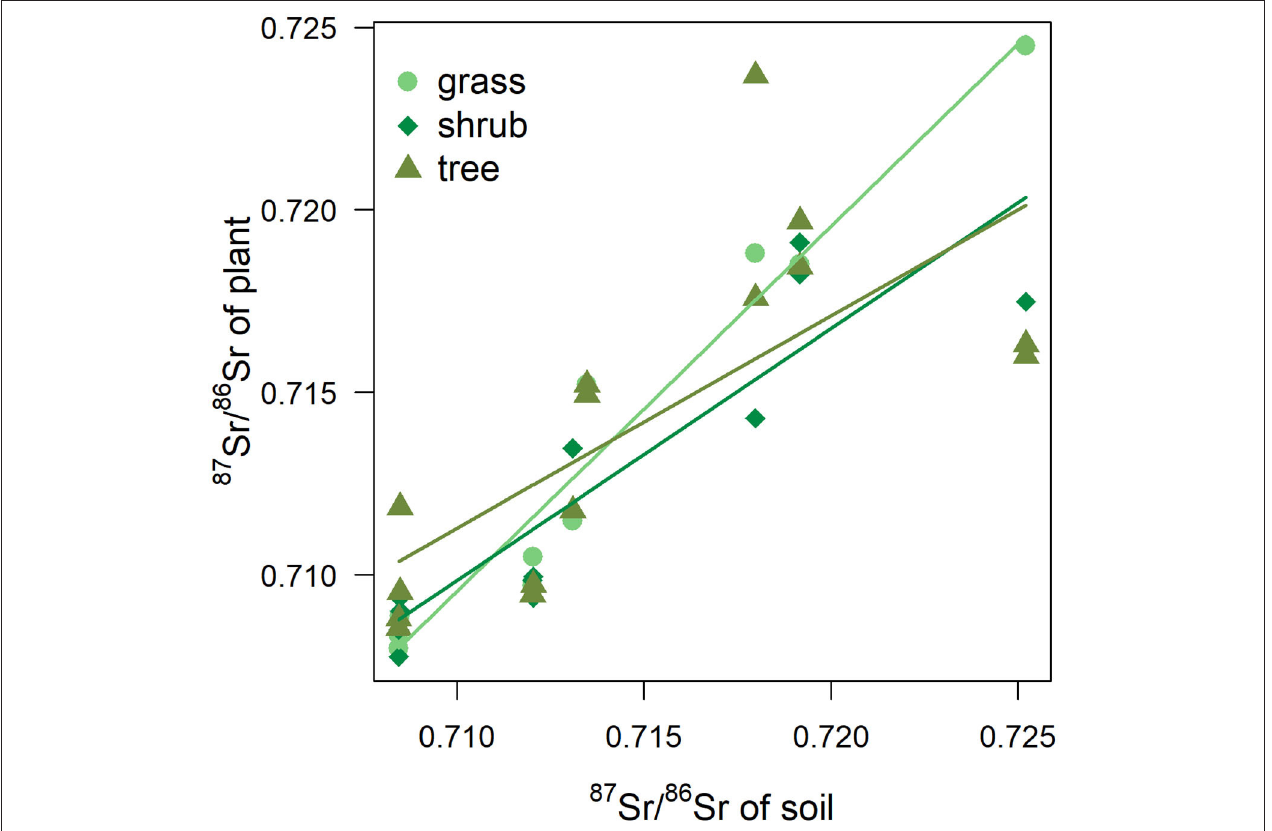
FIGURE 8 | 87 Sr/ 86 Sr values of plant according 87 Sr/ 86 Sr values of soil. Fitted trends correspond to simple linear regressions for each plant type (grass, shrub,